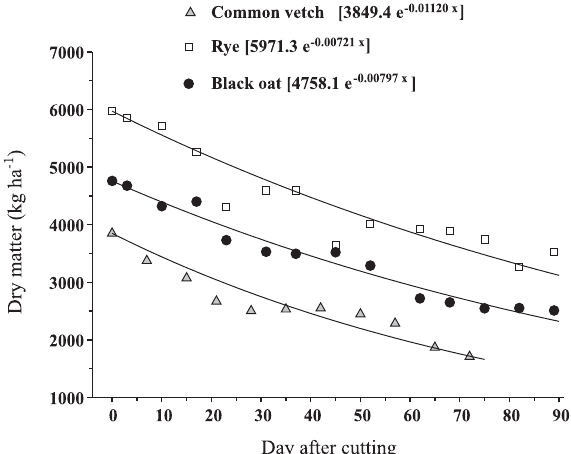
Figure 1. Dry matter of cover plant residues at different times during straw decomposition in no tillage system.